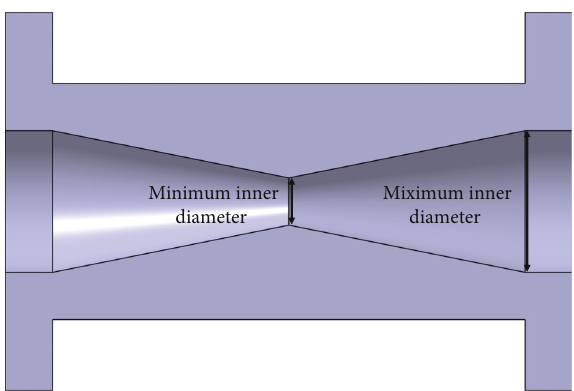
Figure 11: The new inner-varying con fi guration of the shear